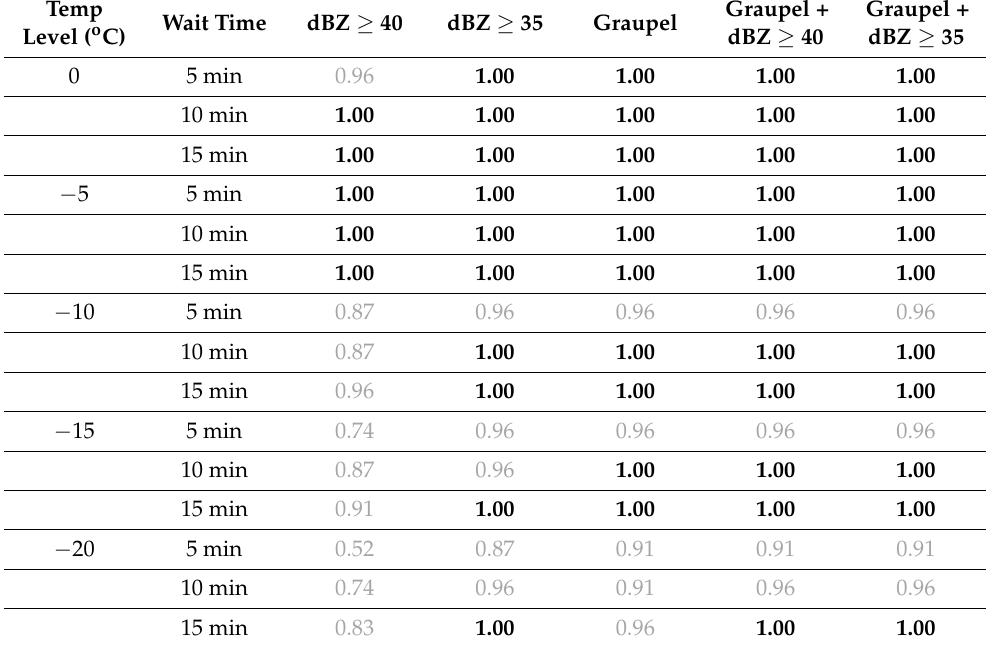
Table 4. The Critical Success Index is defined by the total number of hits divided by the total number of hits, false alarms, and misses: CSI = total hits/(total hits + total false alarms + total misses). Values in boldface represent a CSI of 1.00, which indicates algorithms with a 100% success rate of hits. The remaining values in gray represent algorithms with a CSI < 1.00. This means they had at least one false alarm and/or miss for the 23 storms